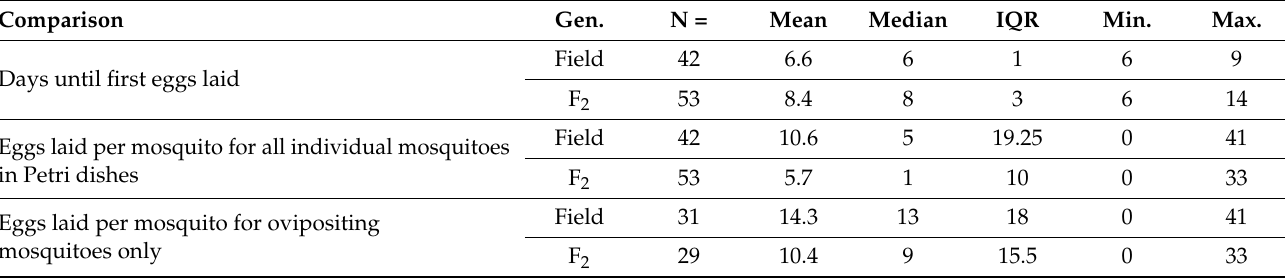
Table 2. Summary table showing mean, median, and IQR for comparisons shown in Figure 5. Mean values are included to facilitate comparisons with previously published work [15,16]. ‘Gen.’ = Generation, ‘N =’ = number of individual